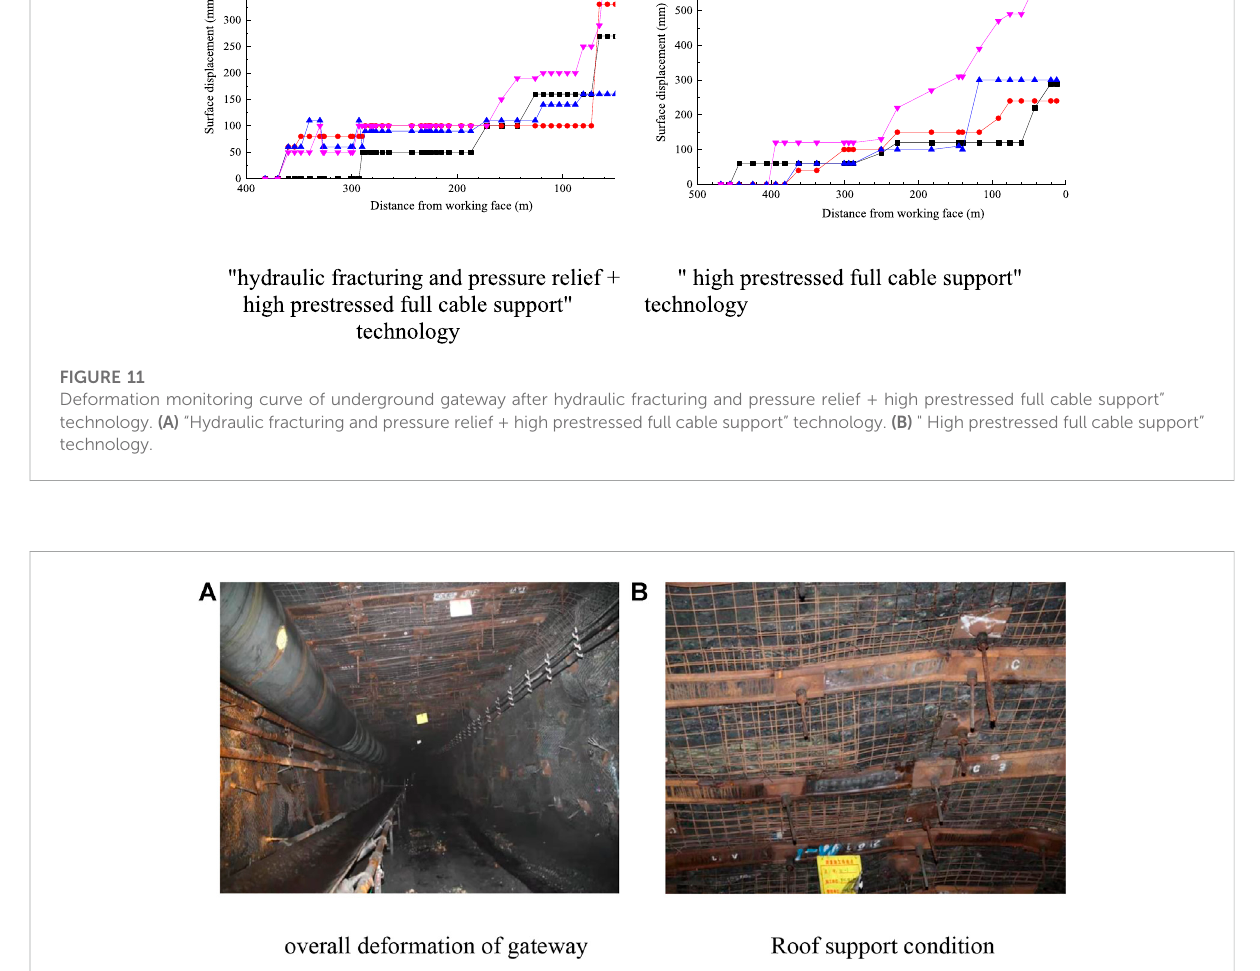
Frontiers in Earth